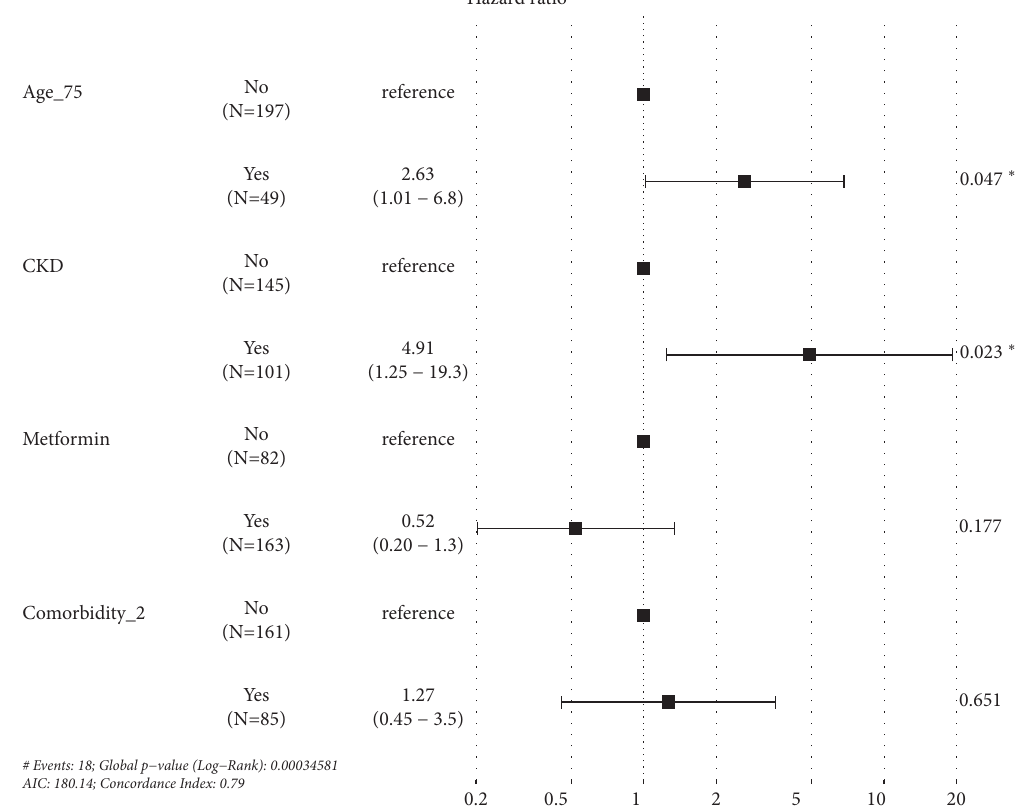
Figure 5: Multivariable Cox analysis of factors associated with all-cause mortality in patients with hypertension and newly diagnosed diabetes after 4 years.